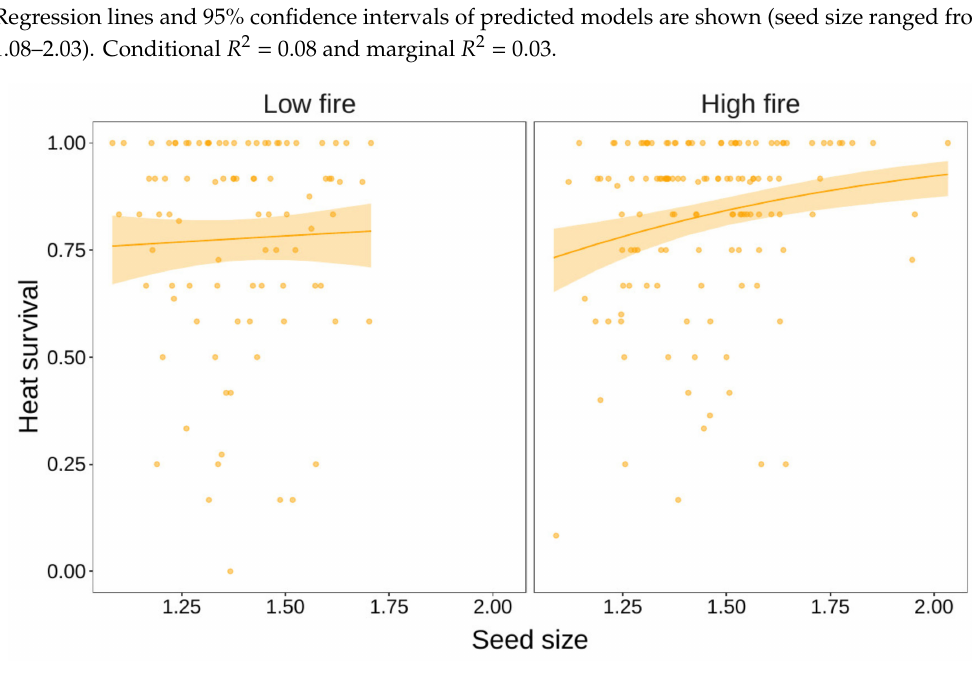
Figure 4. Relationship between seed survival to heat shock and seed size (mm 2 ) in Cistus salviifolius , in ‘low-fire’ coastal shrubland and ‘high-fire’ Mediterranean heathland habitats. Dots represent plant individuals. Regression lines and 95% confidence intervals of predicted models are shown (seed size ranged from 1.08 to 2.03). Conditional R 2 = 0.05 and marginal R 2 =